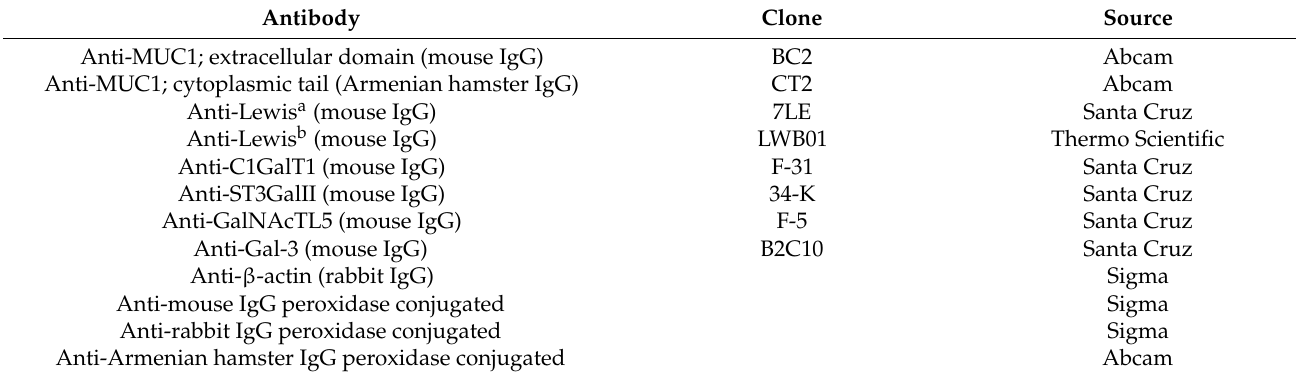
Table 1. Source of